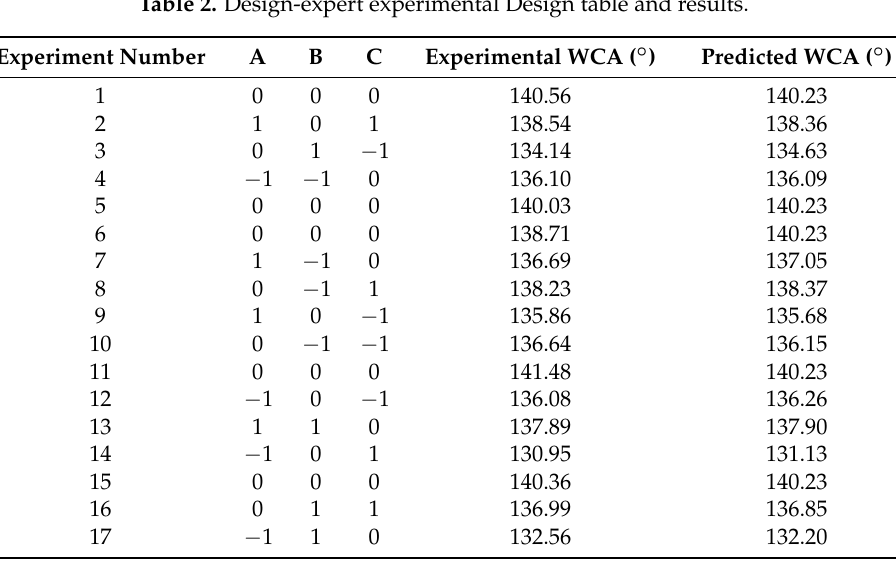
Table 2. Design-expert experimental Design table and results.